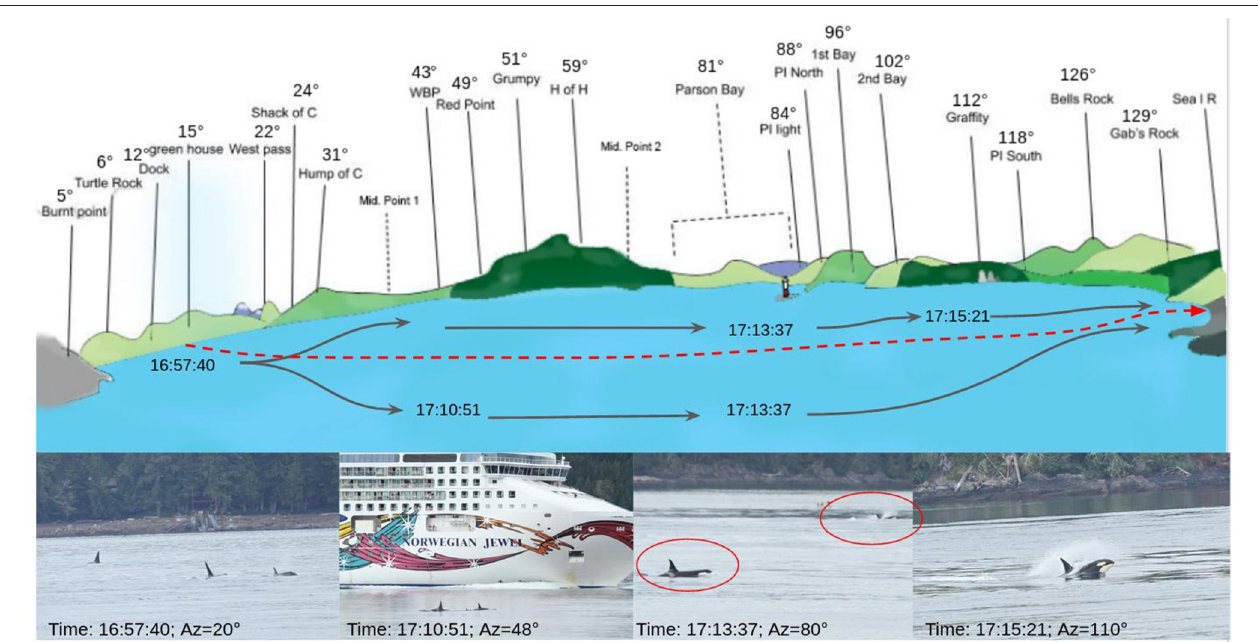
FIGURE 4 | Graph of the passage of the 11th of August. Top: representation of the view of Blackney Pass from Orcalab with the visual position of the group. The red line is the boat trajectory. Bottom: pictures taken from Orcalab